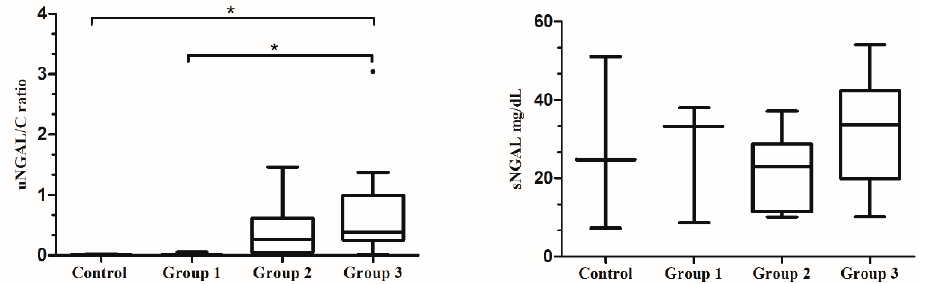
Figure 1. Box plots showing the relationship between uNGAL/C and sNGAL and the different groups of proteinuria degree. Data are presented as boxes and whiskers. Each box includes the 25 and 75 interquartile, whereas the line inside the box represents the median, the whiskers represent the minimum and maximum values. The outlier is shown by a circle. Asterisks indicated significant differences between groups: * p < 0.05.